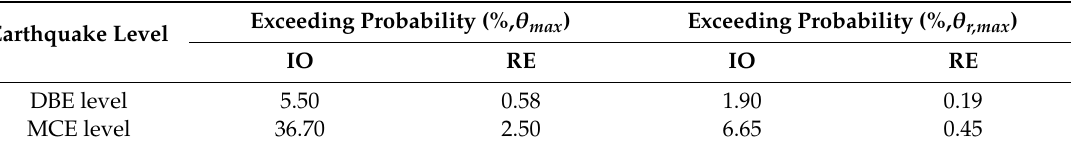
Figure 22. Annual and 50-year exceeding probabilities of novel SCPC frame under near-fault earthquake waves. 6. Further Discussions To verify the great seismic behavior of the novel SCPC frame under near-fault earthquake waves and the accuracy of seismic risk assessment of numerical model, a five-story four-span cast-in-place RC frame (a reinforced concrete frame) and the traditional SCPC frame (a traditional self-centering precast concrete frame without hysteretic dampers) have been modelled by OpenSees. The section sizes and reinforcements arrangement of the two frames are consistent with the prototype structures. Figure 23a displays the analytical connection model of the RC frame; all the structure members are simulated by the Nonlinear Beam Column element. The Joint2D element is adopted in the modelling of the connection core area and is idealized as a parallelogram shaped shear panel with adjacent elements connected to its mid-points. The Joint2D element includes a spring element inside